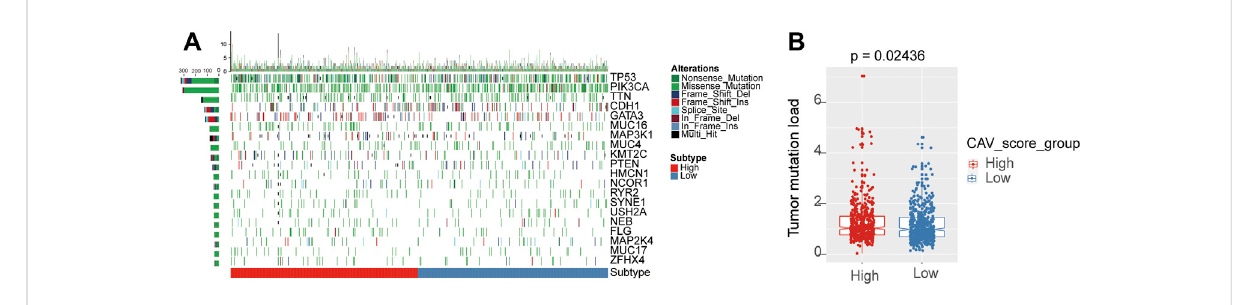
FIGURE 8 Differential landscape of tumor mutation burden between high- and low-risk groups. (A) Mutational landscape showed the frequency of mutated genes in high- and low-risk signature groups. (B) Tumor burden was quantitated by the Wilcoxon test in the risk